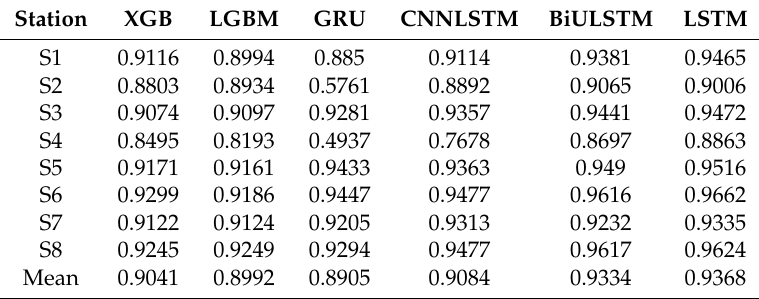
Table 8. Models results for IA